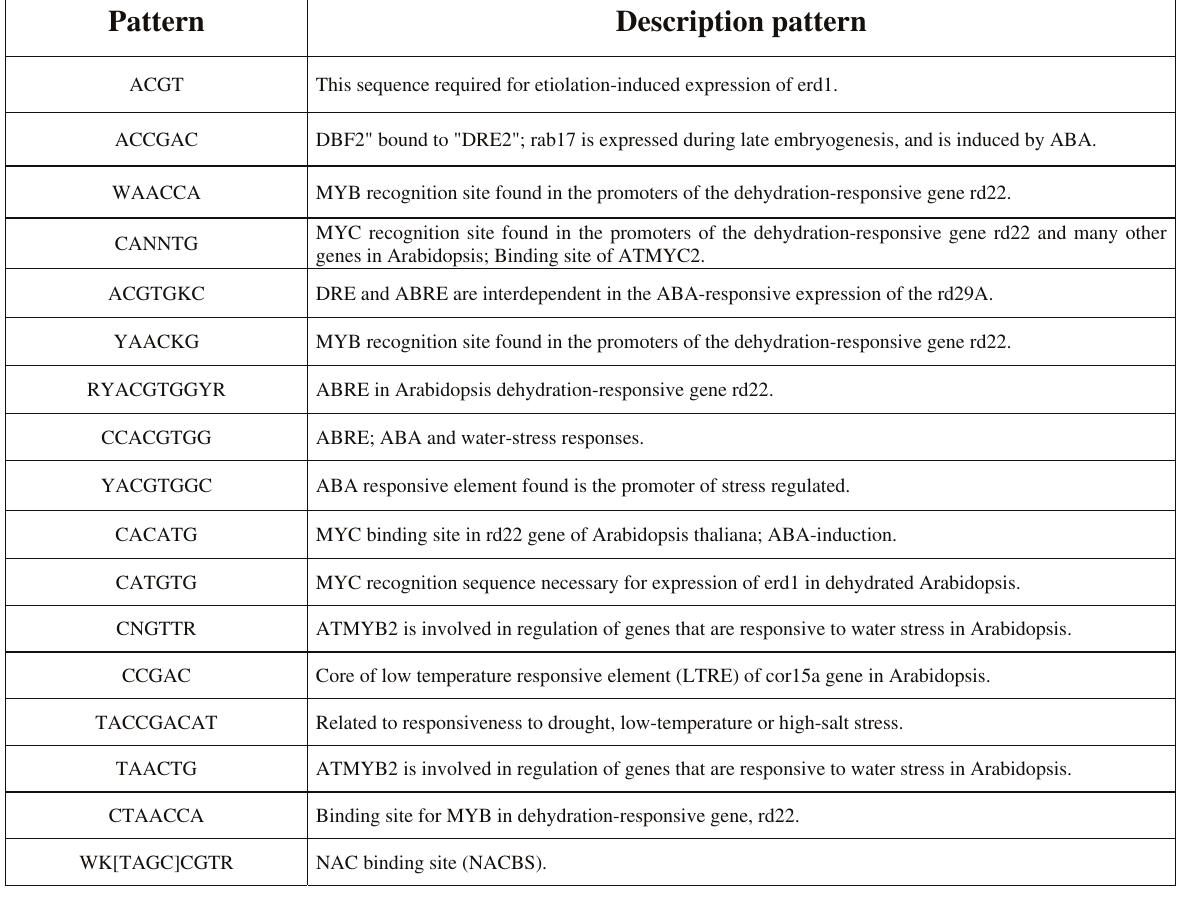
Note: The symbol W was used in addition to A or T; the symbol R was used in addition to A or G; the symbol Y was used in addition to C or T; the symbol K was used in addition to G or T; The symbol W was used in addition to T or A; and the symbol N was used in additional to A,C,G or